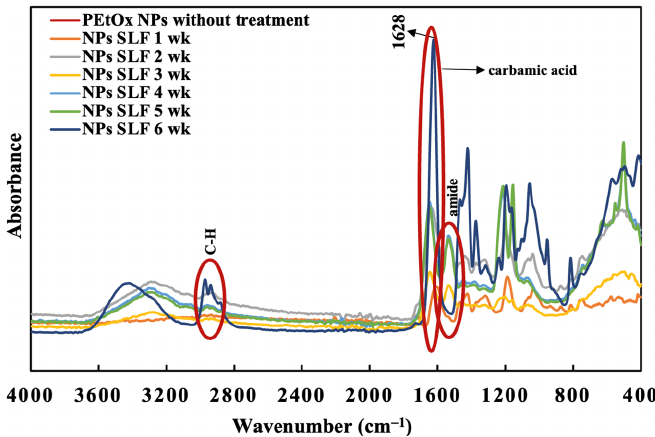
Figure 10. FTIR spectra of PEtOx NPs before and after the incubation period of six weeks in SLF.